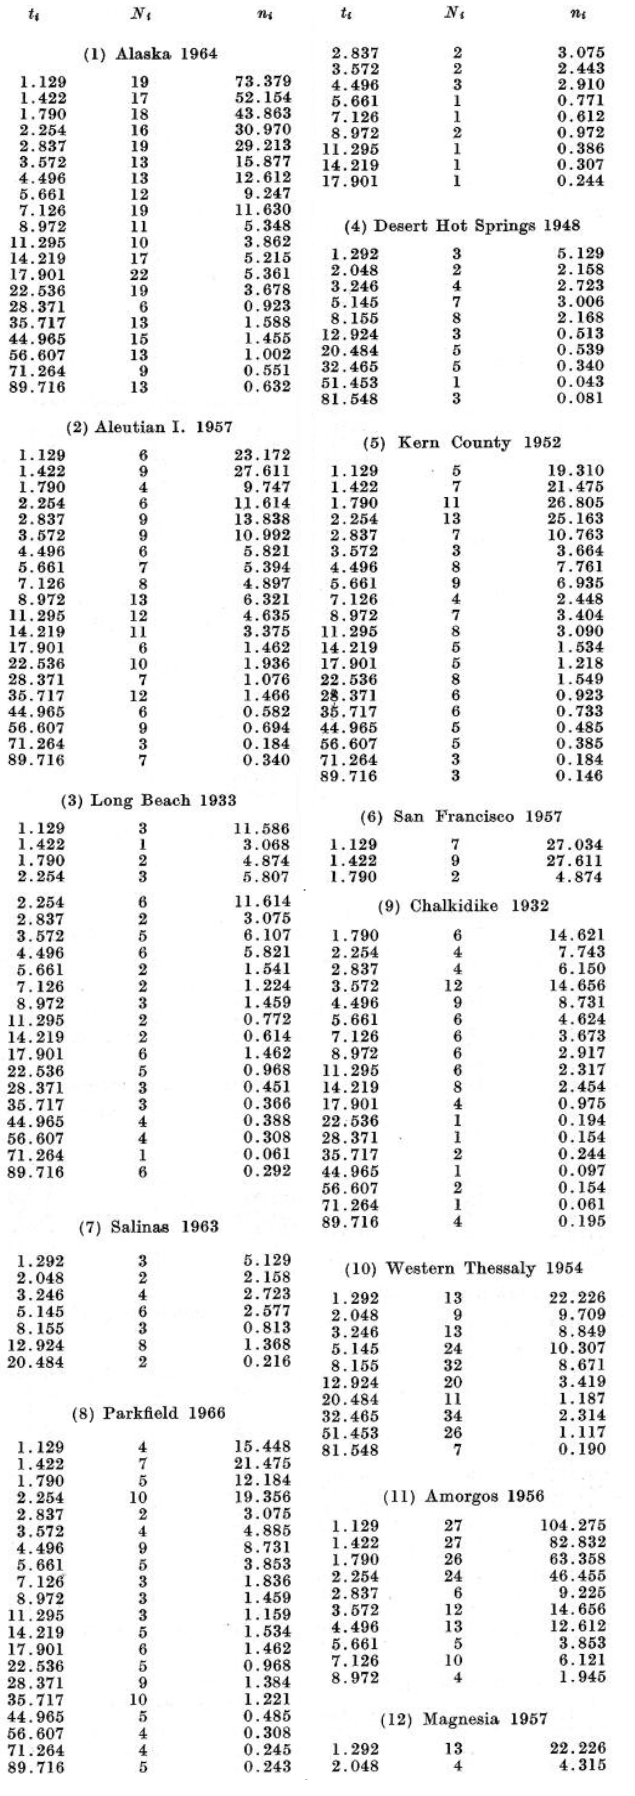
Table 2. Observed frequency of